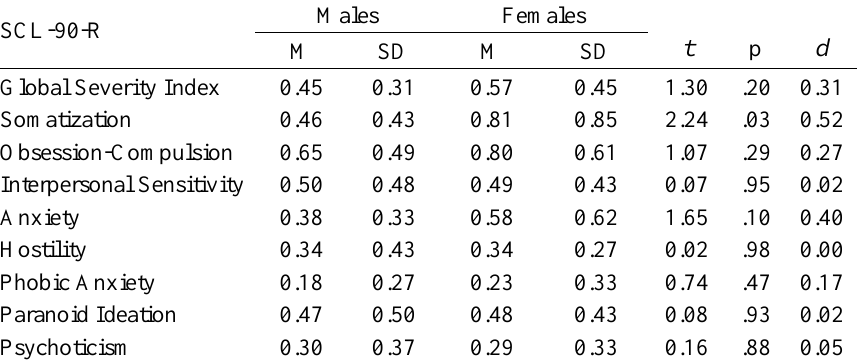
Means, standard deviations and differences in psychiatric symptomatology by sexes SCL-90-R